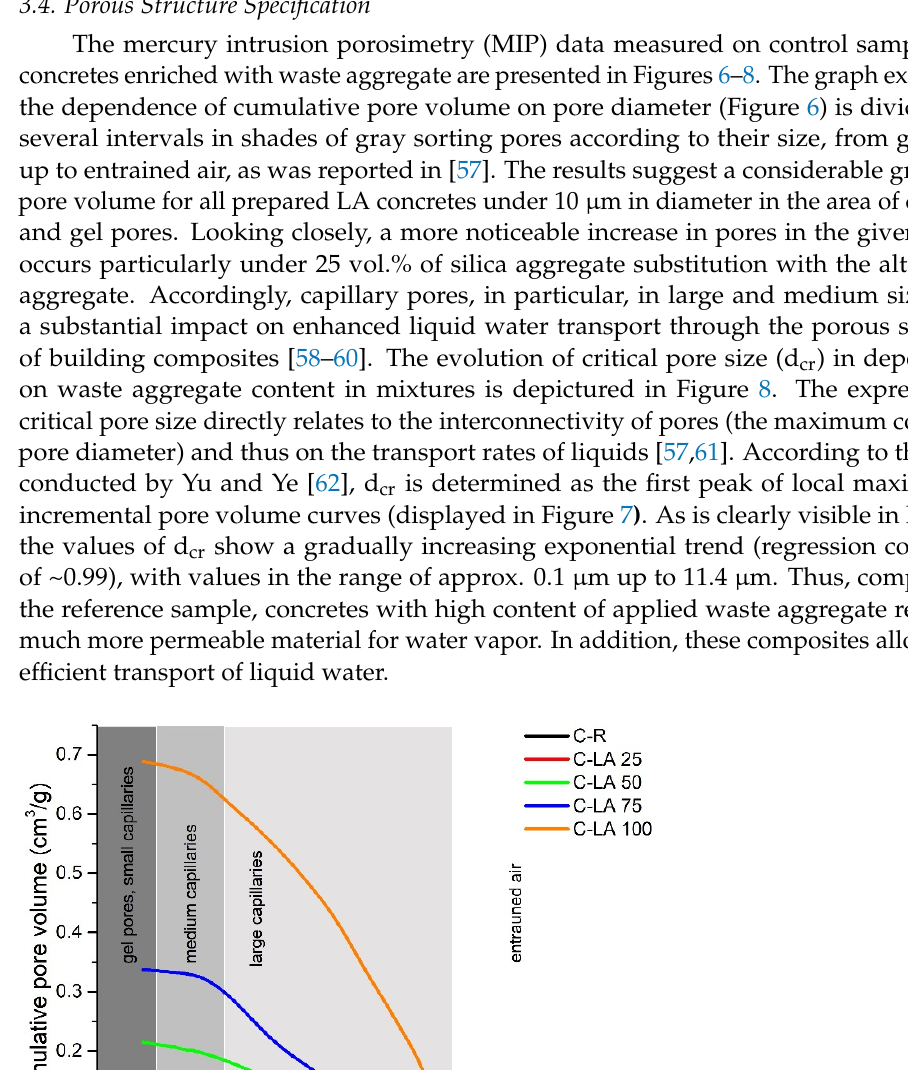
Figure 7. Pore size distribution–incremental pore volume curves measured for control (C-R) and LA dosed samples (C-LA 25–100).